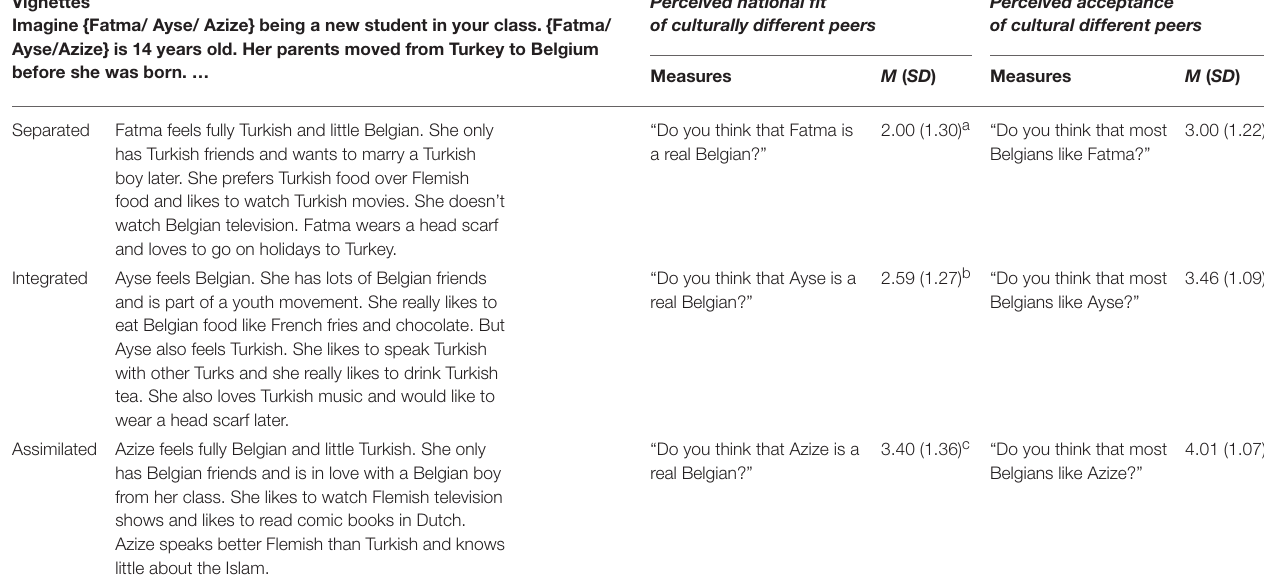
TABLE 1 | Vignettes, means, and standard deviations of perceived national fit and acceptance of (imagined) cultural different peers . Vignettes Imagine {Fatma/ Ayse/ Azize} being a new student in your class. {Fatma/ Ayse/Azize} is 14 years old. Her parents moved from Turkey to Belgium before she was born.